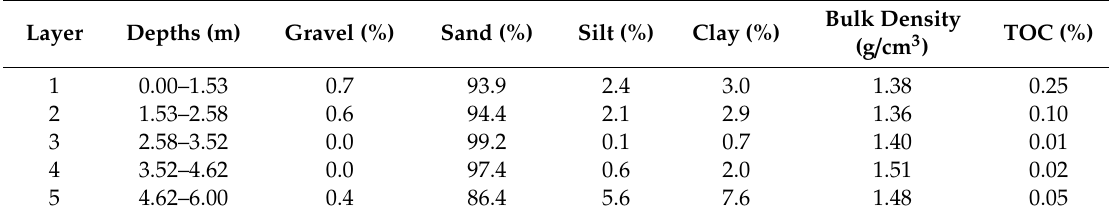
Table 1. Soil layer characteristics of 6 m high soil column with total organic carbon (TOC).